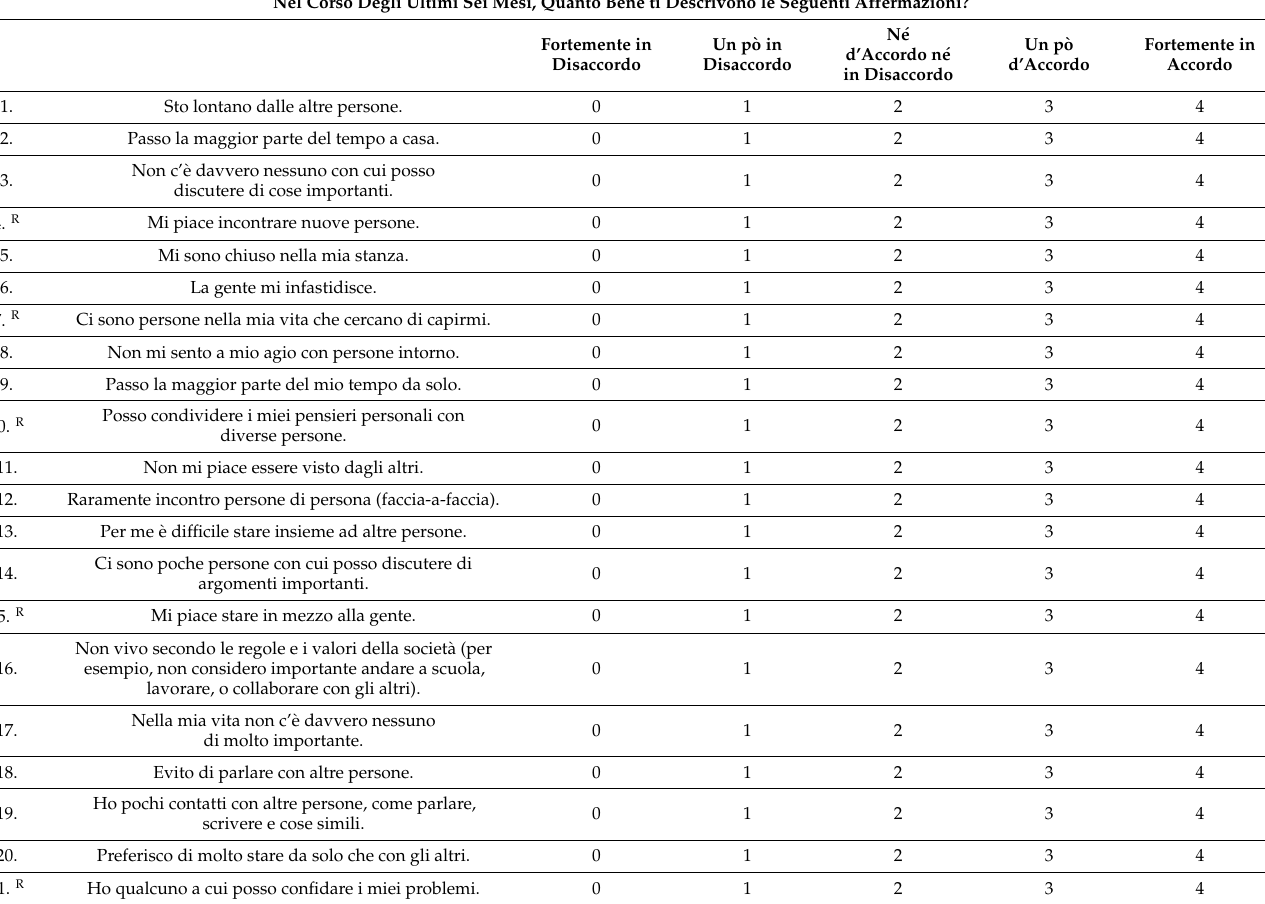
Table A1. The Italian version of the 25-item Hikikomori Questionnaire for